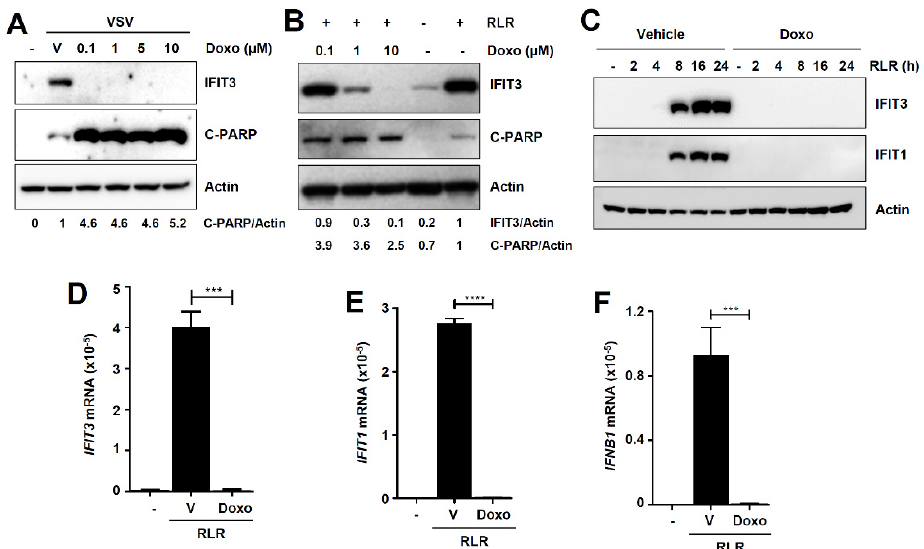
Figure 4. Doxorubicin inhibits the transcriptional activity of IRF3. ( A ) MDA-MB-453 cells were infected with GFP.VSV in the absence or presence of doxorubicin (Doxo, at the indicated doses). IFIT3 and C-PARP were analyzed by immunoblot. ( B ) HT1080 cells were transfected with polyI:C (RLR) in the absence or presence of doxorubicin (Doxo, at the indicated doses). IFIT3 and C-PARP were analyzed by immunoblot 16 h post-RLR stimulation. ( C ) MDA-MB-453 cells were transfected with polyI:C (RLR) for the indicated times in the absence or presence of doxorubicin, IFIT1 and IFIT3 proteins were analyzed by immunoblot. ( D – F ) MDA-MB-453 cells were transfected with polyI:C (RLR) in the absence or the presence of doxorubicin. IFIT3 ( D ), IFIT1 ( E ), and IFNB1 ( F ) mRNA levels were analyzed by qRT-PCR analyses 8 h post-RLR. Vehicle (V), DMSO treatment, *** indicates p < 0.001, **** p < 0.0001.